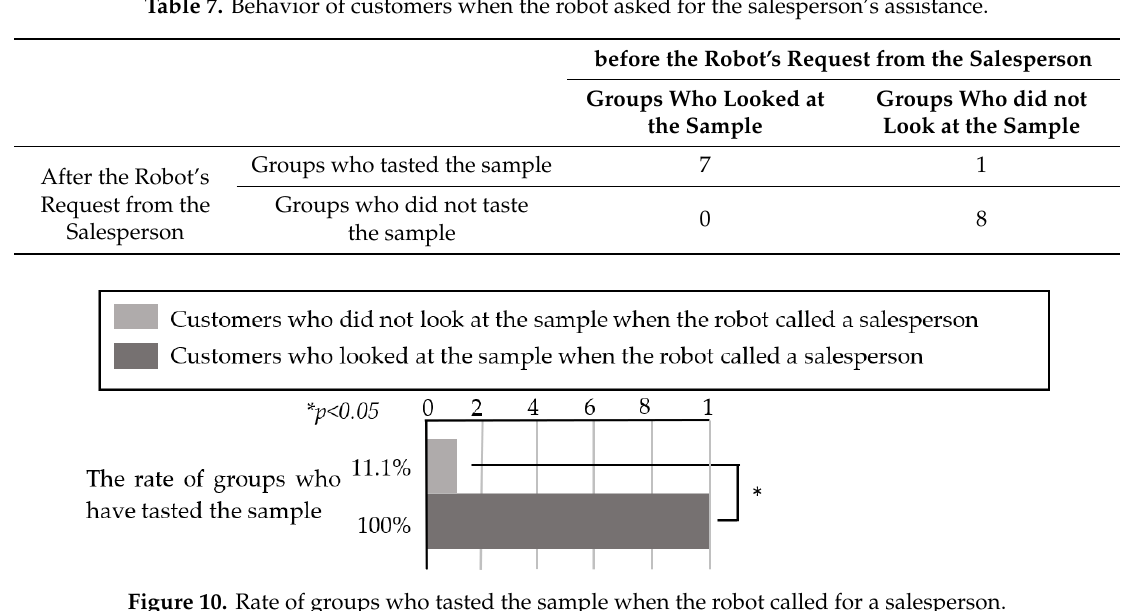
Table 7. Behavior of customers when the robot asked for the salesperson’s assistance.